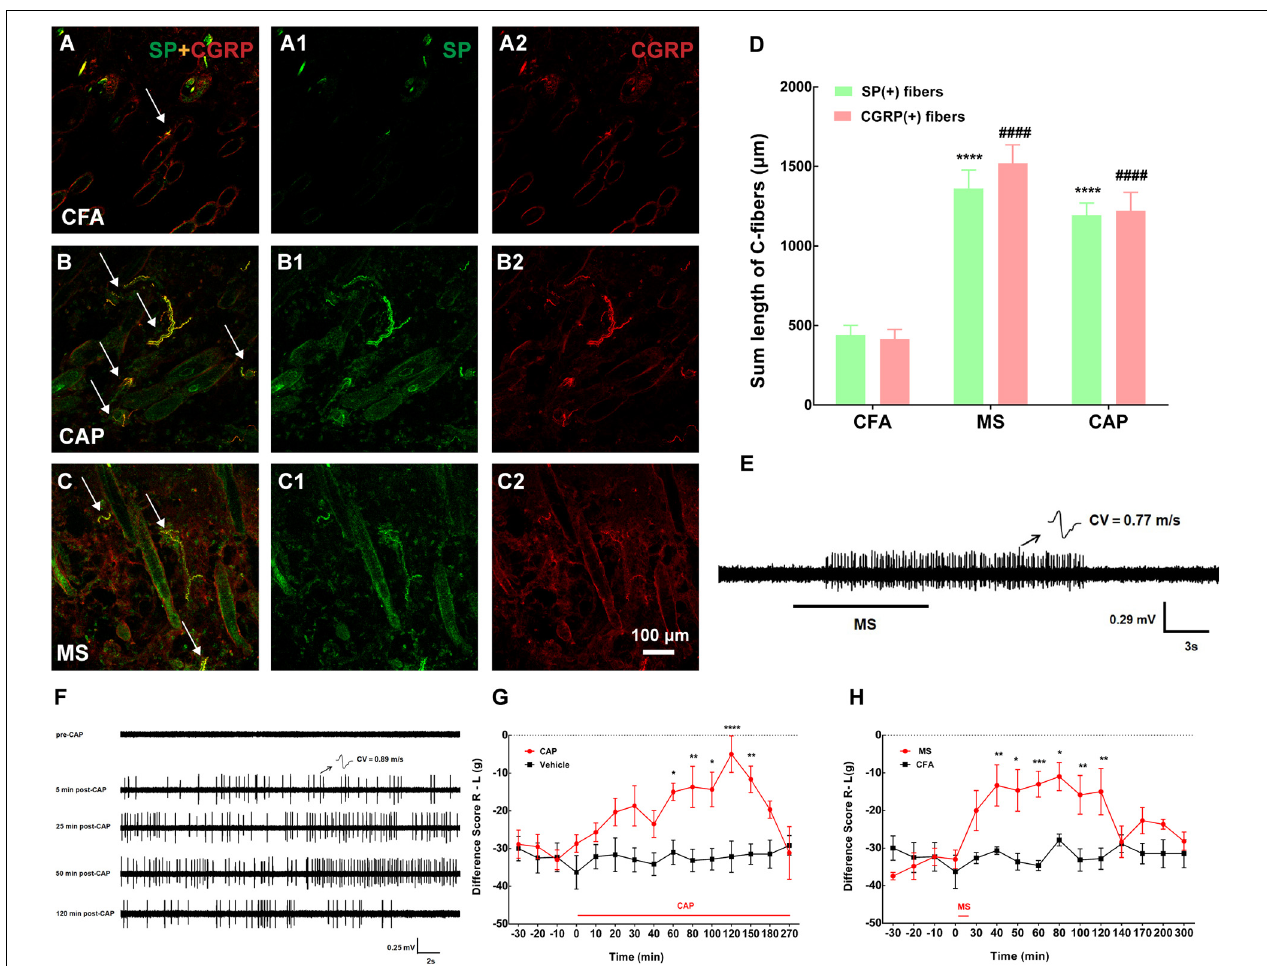
FIGURE 4 | Both capsaicin (CAP) and moxibustion-like stimulation (MS) activated cutaneous C-fibers and substance P (SP)/calcitonin gene-related peptide (CGRP)-immune-reactive (IR) fibers and produced pain relief. (A–C) Double staining showed cutaneous SP-IR (green) or CGRP-IR (red) fibers in the BL57 in the three groups. MS or CAP intervention activated numerous SP/CGRP-IR fibers. (A1,A2,B1,B2,C1,C2) represented SP (A1,B1,C1 in green) and CGRP (A2,B2,C2 in red) in panels (A–C) , respectively. Double labeling of SP-IR and CGRP-IR fibers was in yellow (white arrow). (D) The summed lengths of SP/CGRP-IR fibers were longer after MS. SP: **** p < 0.0001 vs. complete Freund’s adjuvant (CFA); CGRP: #### p < 0.0001 vs. CFA ( n = 15 sections selected randomly from 3 to 4 rats). (E) Representative traces of noxious MS activating cutaneous C-fiber afferents [conduction velocity (CV) = 0.77 m/s]. (F) Representative traces of CAP-evoked C-fiber firings. CAP application activated cutaneous C-fiber afferents (CV = 0.89 m/s) after 5 min and lasted for about 120 min. (G,H) The difference score of weight-bearing increased after MS and CAP application, respectively. * p < 0.05, ** p < 0.01, *** P < 0.001, or **** p < 0.0001, significant difference between groups at each time point (Holm–Sidak post-test, n =